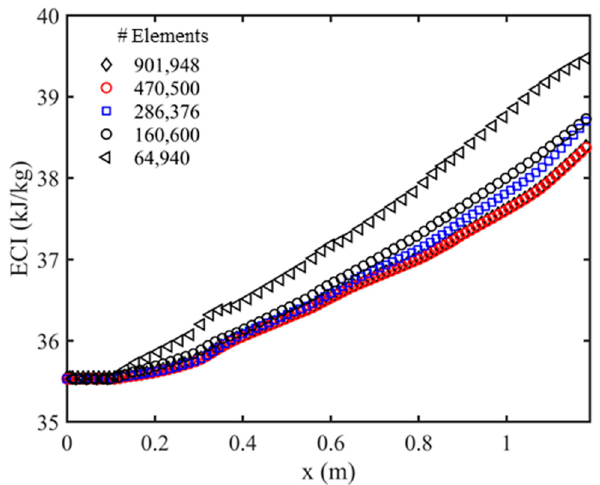
Figure 2. The mesh independency analysis by calculating ECI along x -axis for an ambient temperature of 300 k, relative humidity of 15%, the broilers heat production of 150 W · m − 2 and air velocity of 0.5 m/s.